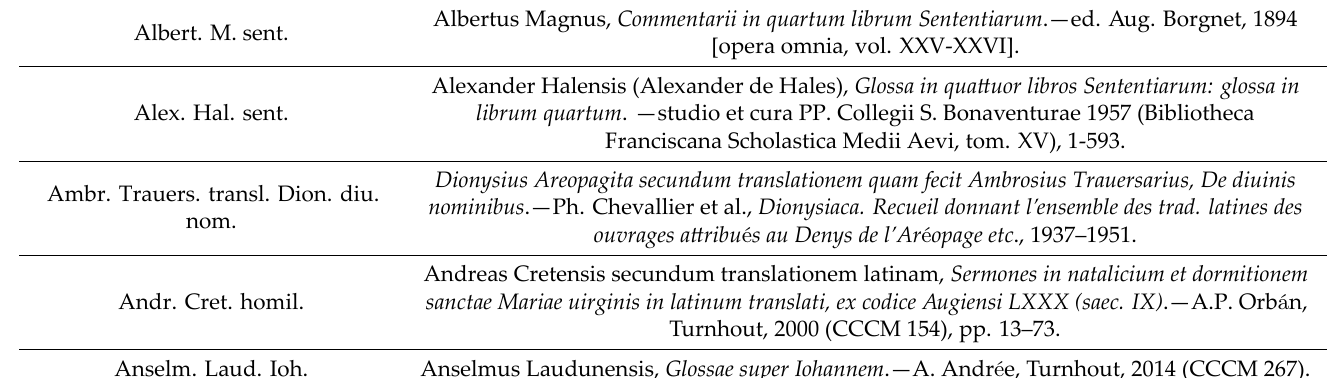
Table A2. Texts not indexed by the ThLL and NGML